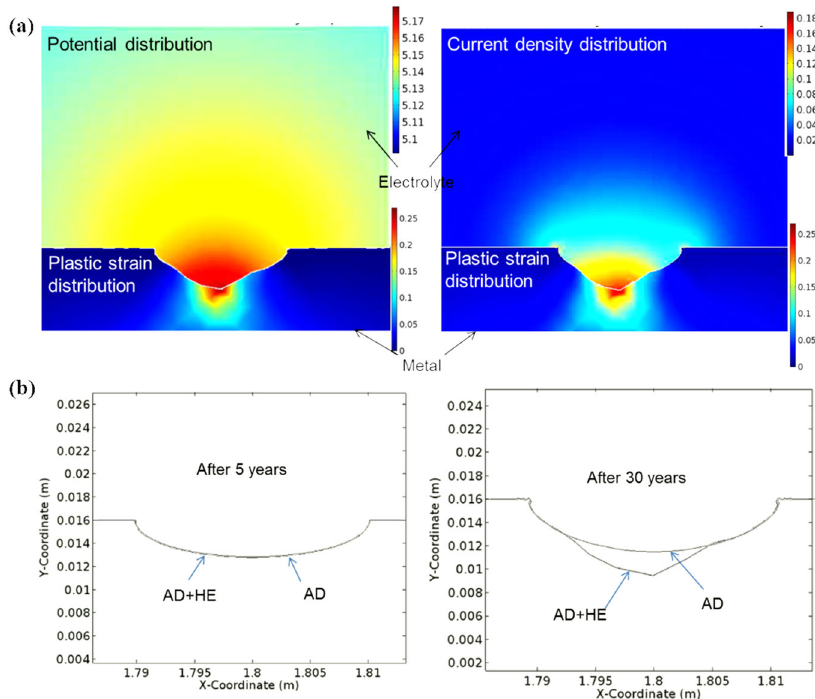
Fig. 8 Primary simulation results from the proposed model. a Contour distributions of the electrochemical and mechanical features after 30 years of corrosion. b Role of HAC part under different corrosion